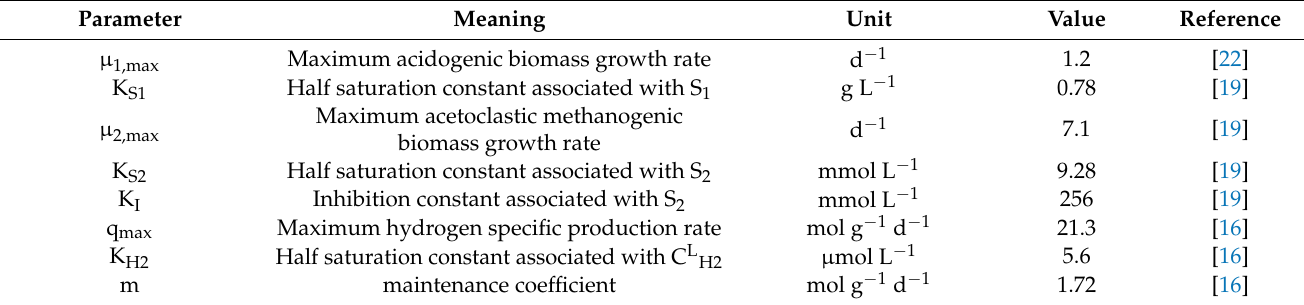
Table 1. Value of the kinetic parameters referred to all the biological